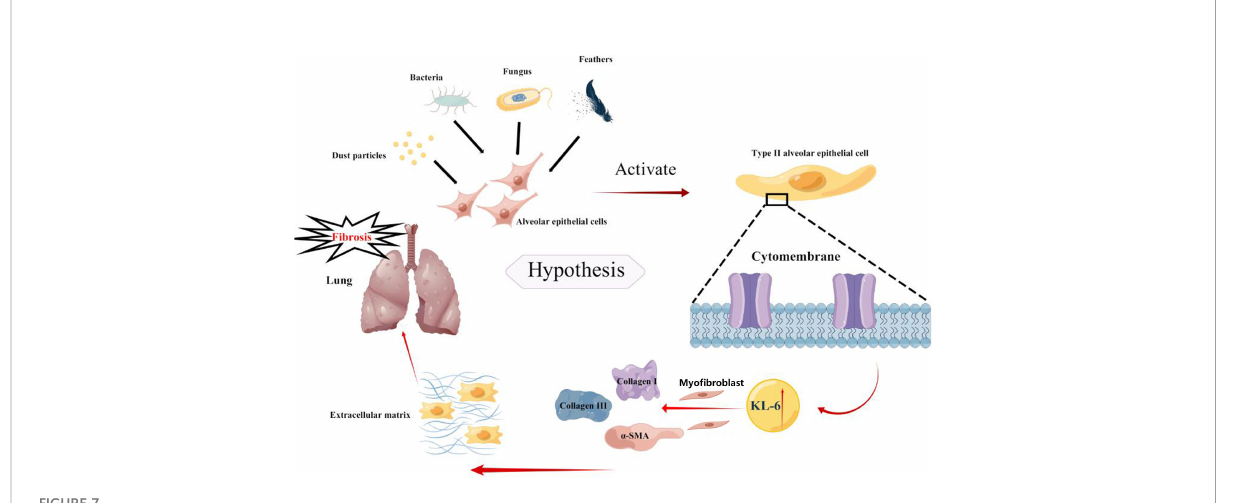
FIGURE 7 The possible potential mechanism of KL-6 in